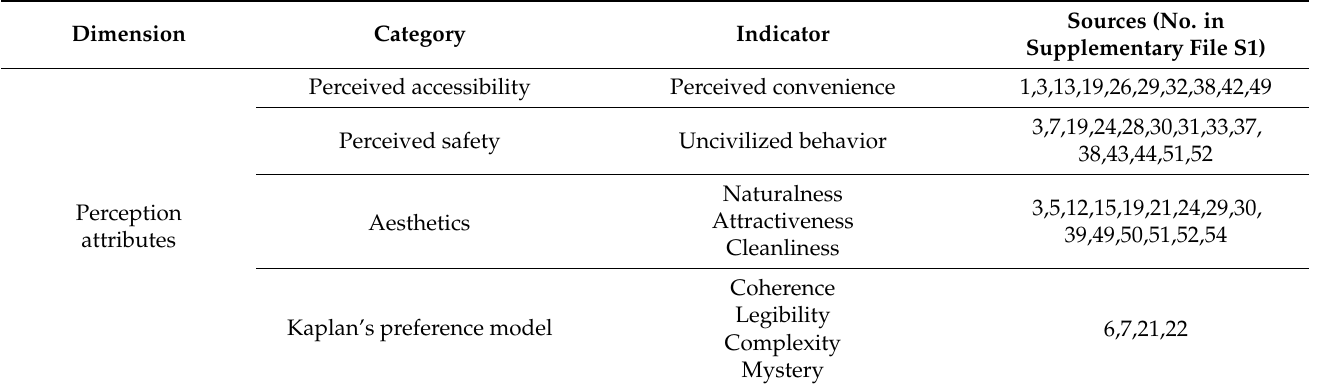
Table 6. Indicators of Perception attributes.